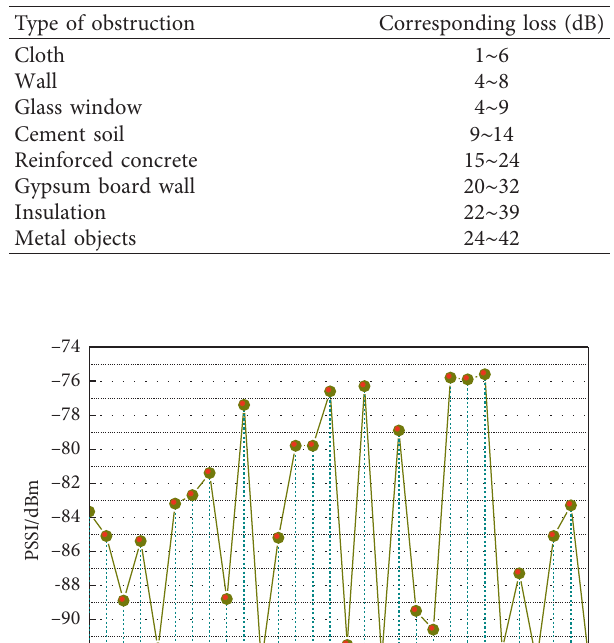
Table 1: Loss of common indoor objects to electromagnetic waves.